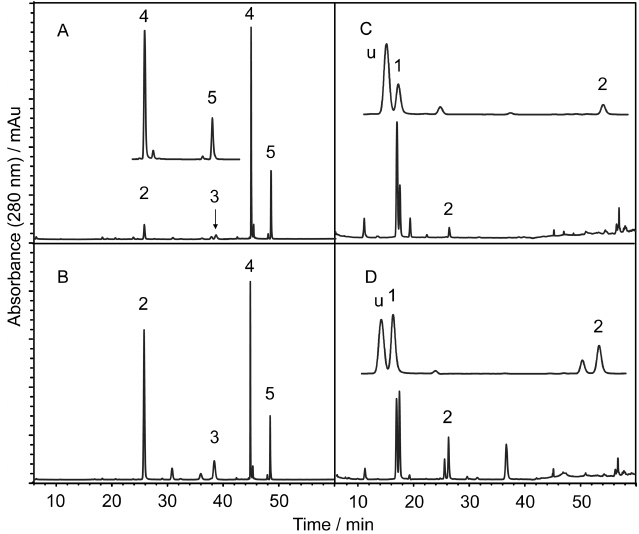
Figure 3. The representative chromatograms of different parts of S. baicalensis . ( A ) root bark; ( B ) taproot; ( C ) pod; ( D ) corolla; 1 = scutellarin; 2 = baicalin; 3 = wogonoside; 4 = baicalein; 5 = wogonin; u = unknown compound. All of the chromatograms are recorded at 280 nm.